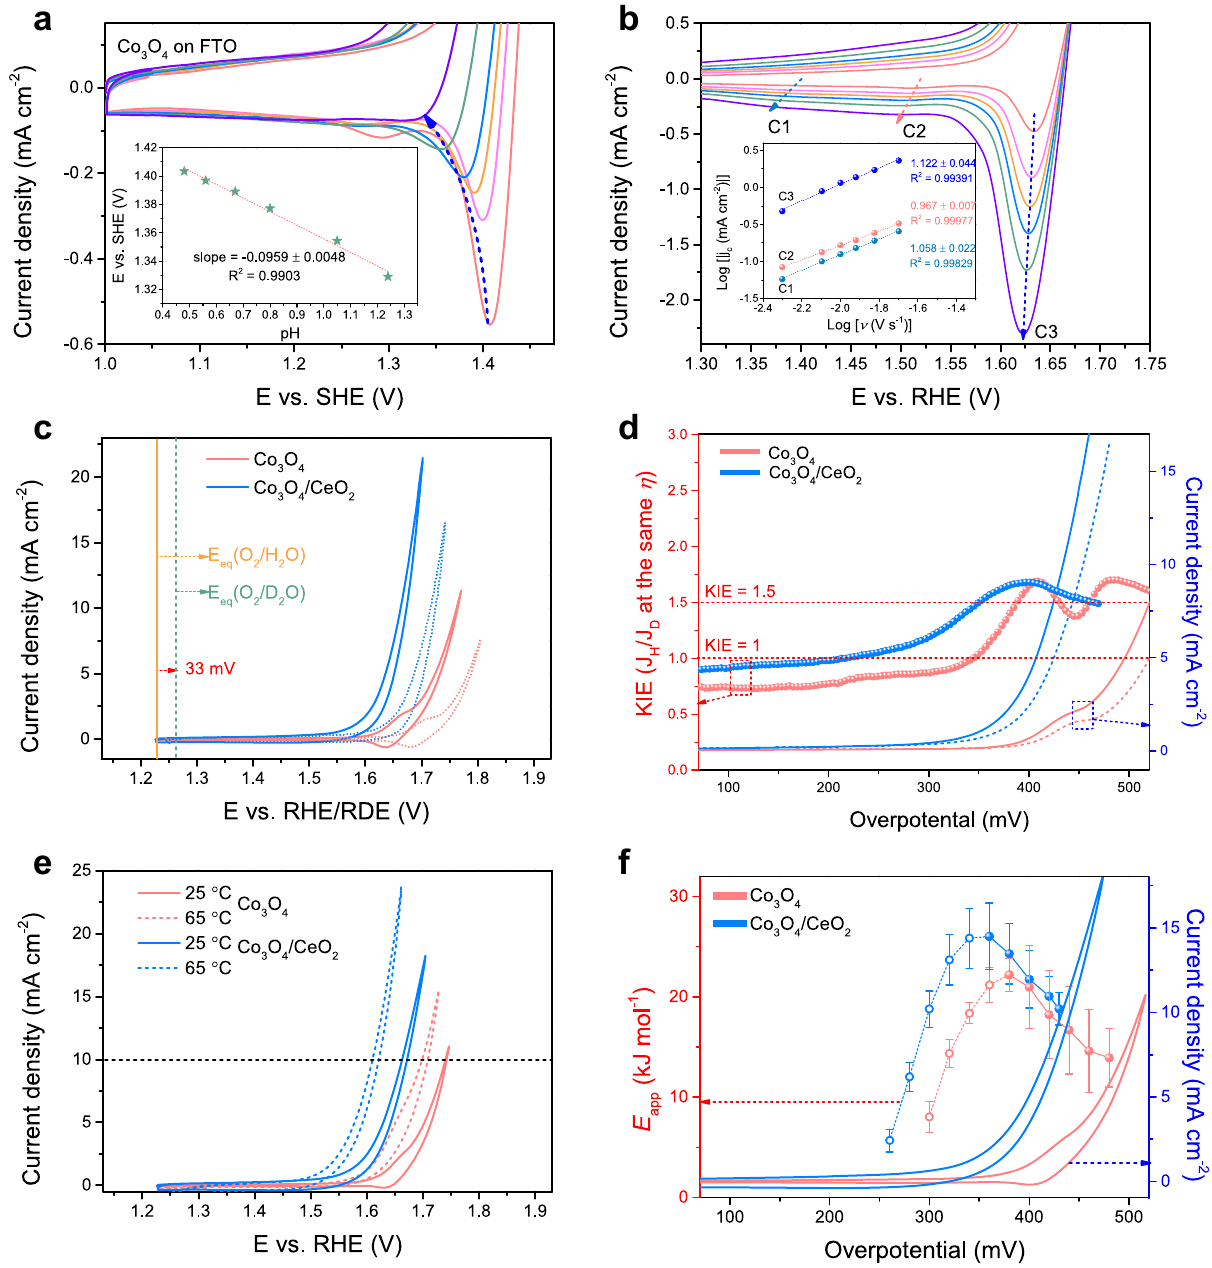
Fig. 3 The pH-dependence, kinetic isotope effect (KIE) and apparent activation energy ( E app ) analyses of the acidic OER on Co 3 O 4 and Co 3 O 4 /CeO 2 catalysts on FTO electrodes. a CV curves of Co 3 O 4 recorded in H 2 SO 4 solutions with different pH values, the inset shows the C3 peak potential vs. SHE plotted against the solution pH. b CV curves of Co 3 O 4 recorded at different scan rates in 0.5 M H 2 SO 4 solution, the inset shows the logarithm of cathodic peak current density ( j c ) plotted against the logarithm of scan rate ( ν ). c CV curves of both catalysts recorded in 0.5 M H 2 SO 4 in H 2 O solution on the RHE scale (solid) vs. in 0.5 M D 2 SO 4 in D 2 O solution on the RDE scale (dashed). d The KIE curves plotted with the LSV curves adapted from ( c ) but presented on the overpotential scale. e CV curves of both catalysts recorded in 0.5 M H 2 SO 4 solution at 25 vs. 65 °C. f The corresponding E app data point and error bar are calculated from CV curves recorded at different temperatures (see Supplementary Fig. 18 for